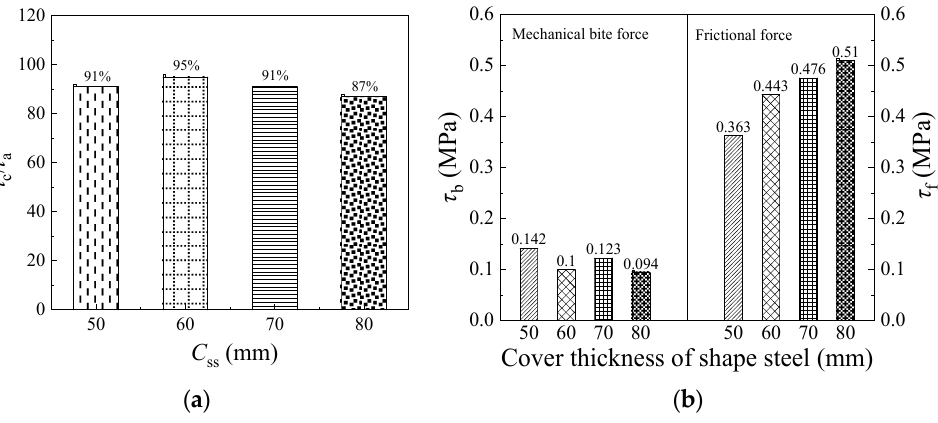
Figure 14. The effect of cover thickness of steel on the bonding capacity. ( a ) The effect of cover thickness of steel on l c / l a ; ( b ) effect on the mechanical biting stress and friction resistance stress.